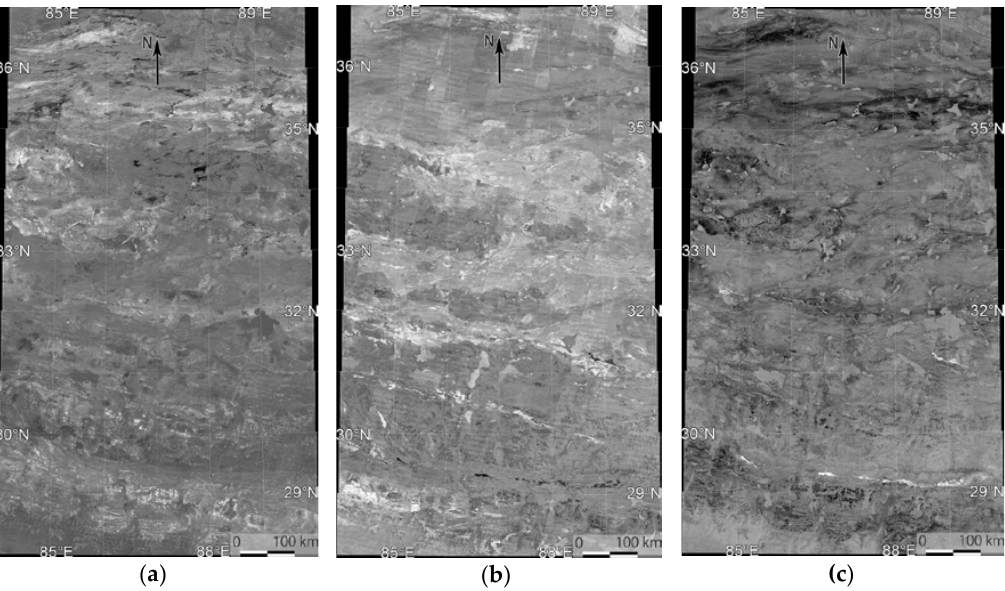
Figure 5. Grayscale image of the indices ( a ) QI with a linear contrast stretch of the histogram region 0.95 to 1.1; ( b ) CI with a linear contrast stretch of the histogram region 1.005 to 1.055; and ( c ) MI with a linear contrast stretch of the histogram region 0.75 to 0.98, produced using the same ASTER dataset of Figure 4 covering the study area. The extent of the study area and the map projection are described in the caption in Figure 2.